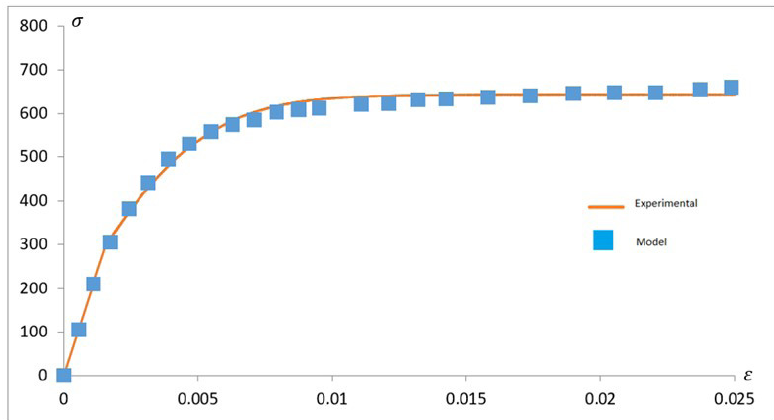
Figure 11. Comparative stress curve (MPa) - strain (mm / mm) - ε_1=